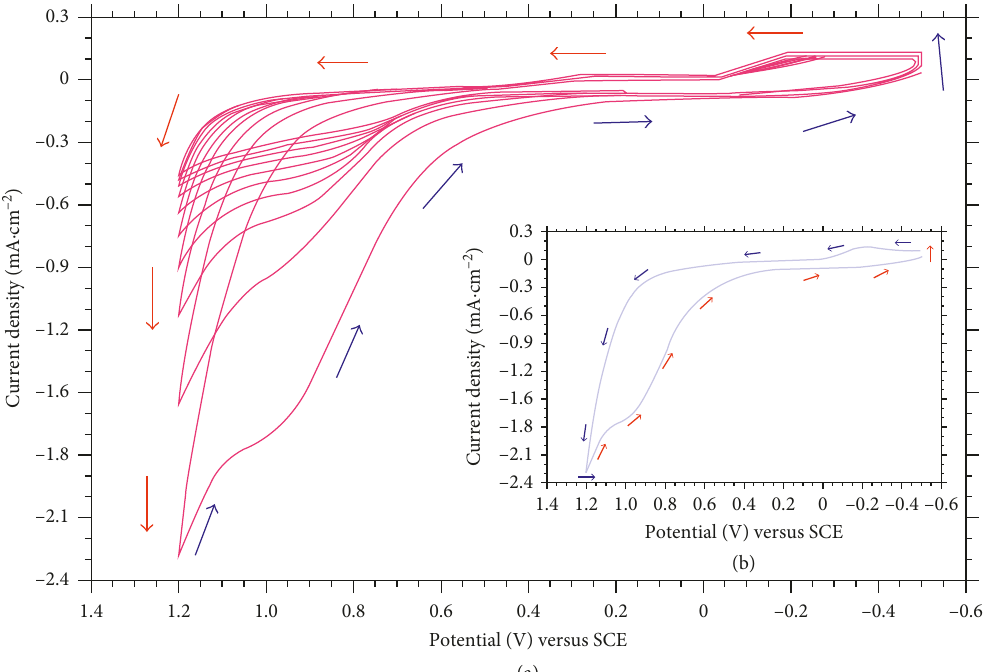
Figure 1: Cyclic voltammograms for the PEDOT-HNT composite coating on alkali-treated Ti alloy substrates for cycle numbers 1–20 at a scan rate of 50mV s ·